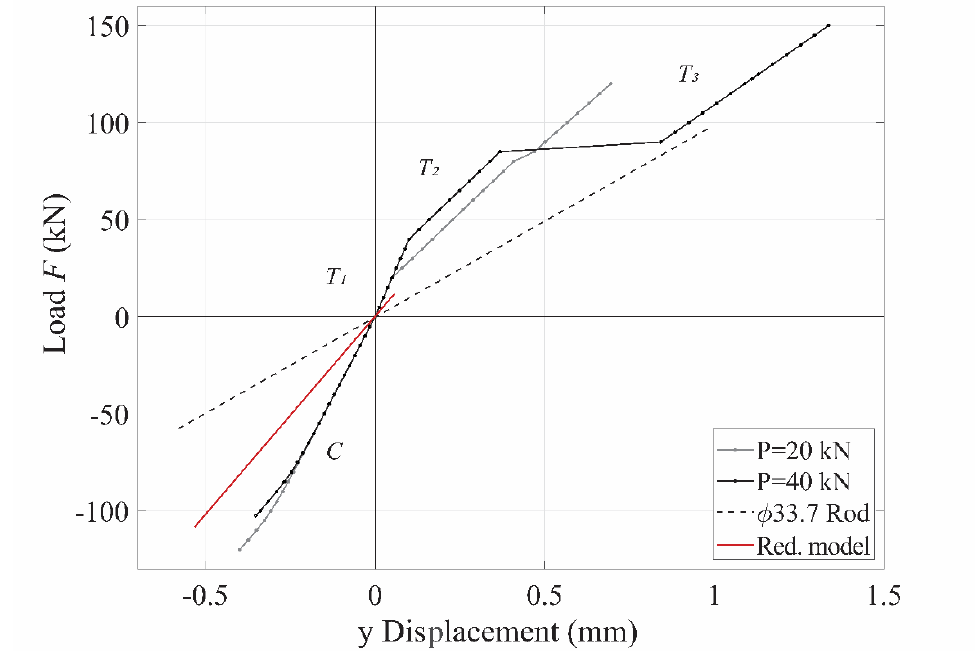
Fig. 12 Load-displacement curve of an ideal reinforced and post-tensioned edge of the shell (two cases with 𝑃 = 20 𝑘𝑁 and 𝑃 = 40 𝑘𝑁 pre- loaded cables). The main differences between the 𝑃 = 40 𝑘𝑁 curve with respect to the 𝑃 = 20 𝑘𝑁 curve are that (a) the length of the segments is different, and as it can be easily imagined this is a function of the post-tension rate; and (b) there is a marked nonlinearity occurring between the segments T 2 and T 3 , which is interpreted as the failure of the cable due to the high post-tensioning stress rate. In fact, the last part of the curve has a stiffness 𝐸 𝑇 that results lower than 𝐸 𝑅+𝐶 , 3 and, excluding secondary effects caused by glass tensioning, approaches the 𝐸 𝑅